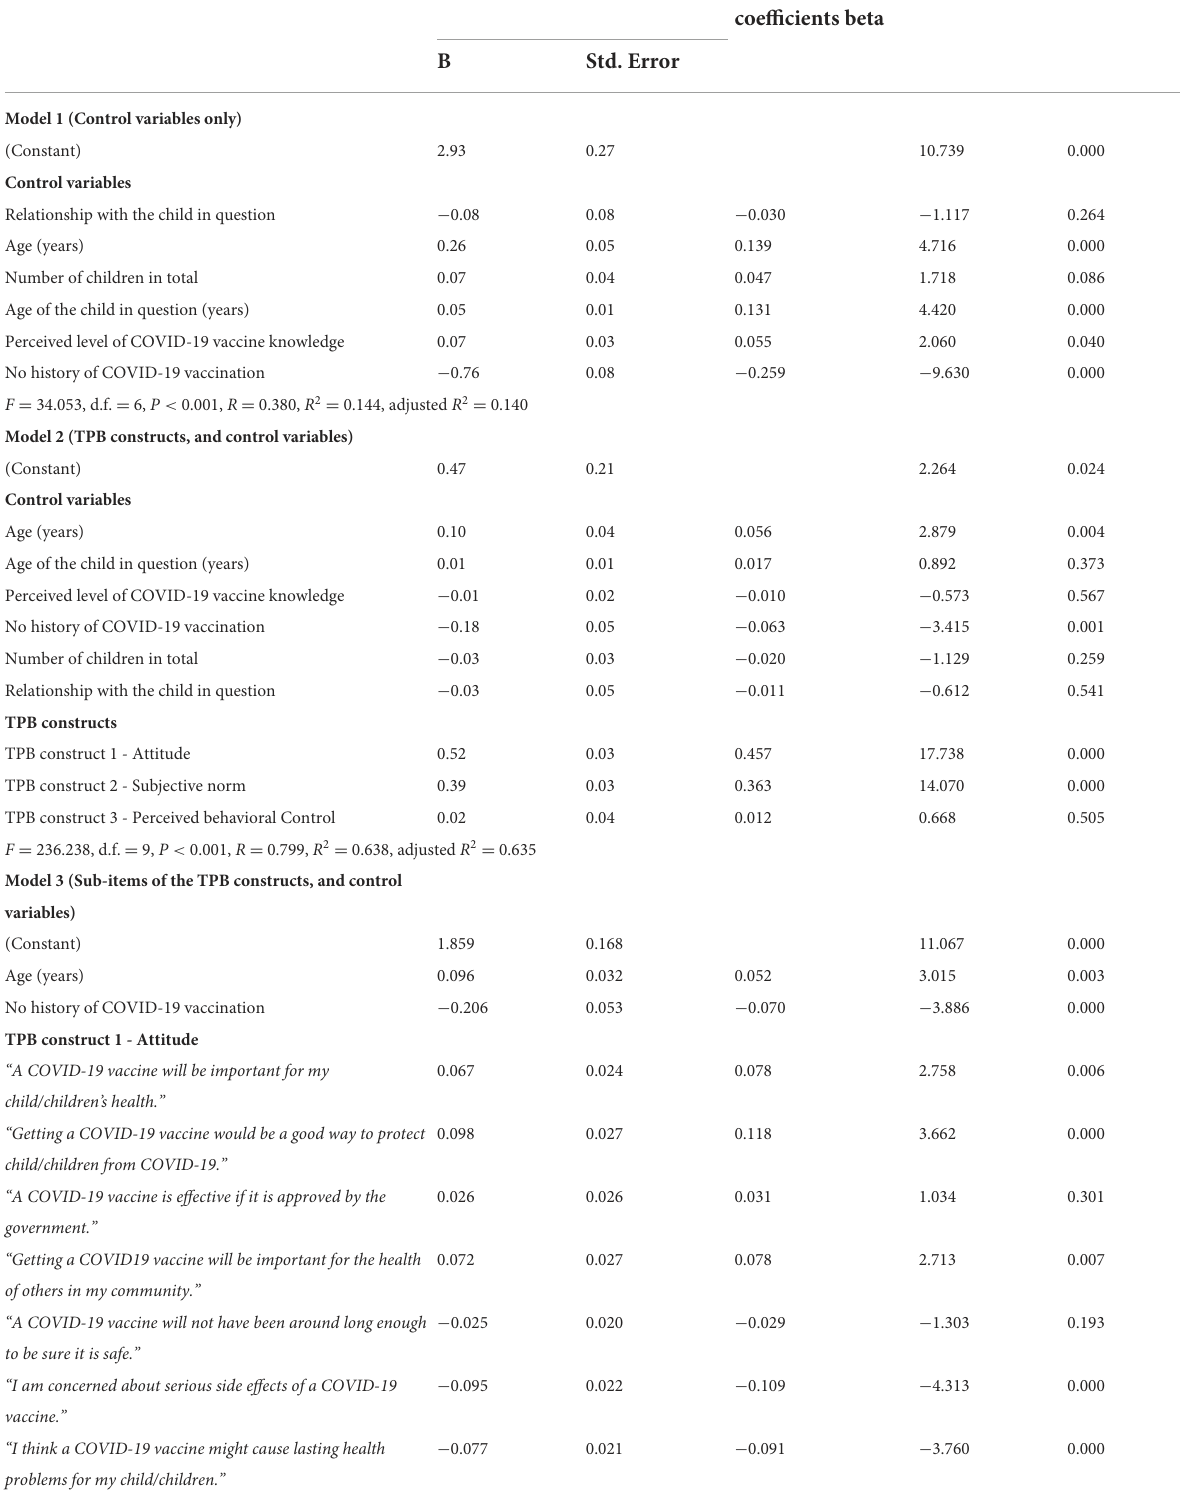
TABLE 3 Results of multiple regression